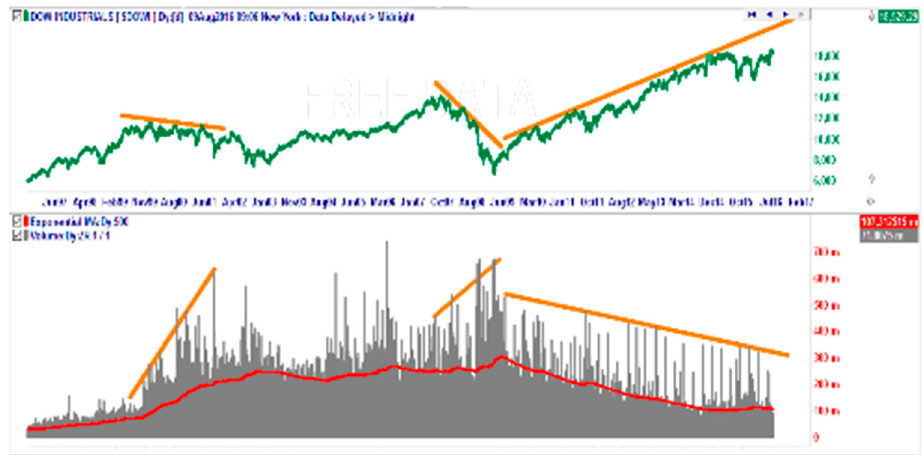
Figure 11. Volume divergence. Source: Authors’ processing is based on data available on Incredible Charts Pro.